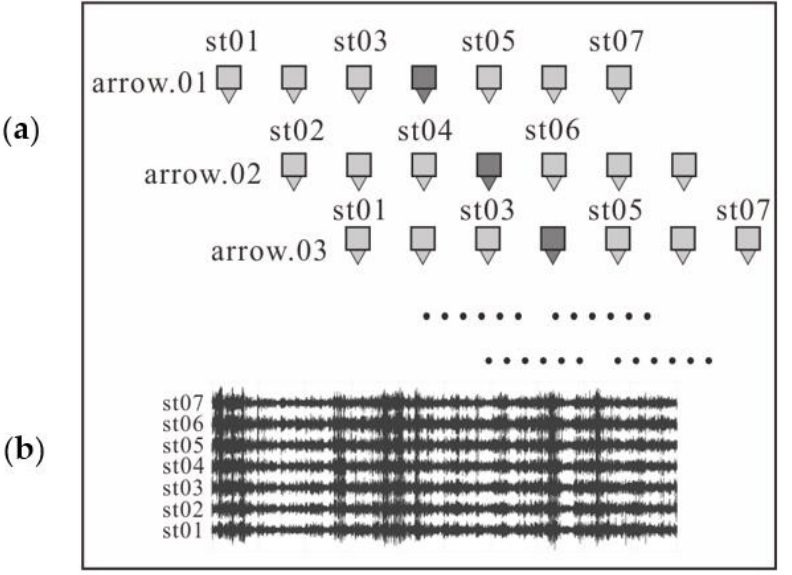
Figure 4. Schematic layout of field data acquisition. ( a ) Diagram of station observation system. ( b ) Wave diagram of data collected by 7 seismic stations.